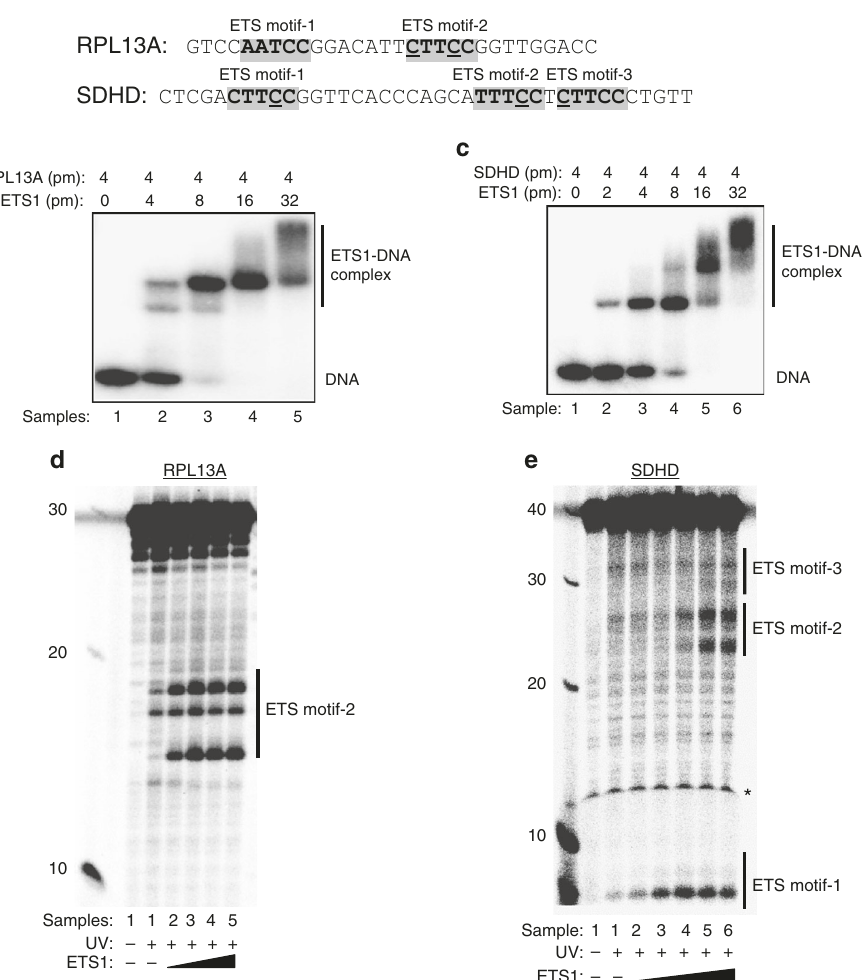
Fig. 5 Binding of ETS1 protein promotes UV damage formation in vitro. a DNA sequences of RPL13A and SDHD promoter fragments, corresponding to chromosome coordinates chr19:49990710-49990681 and chr11:111957515-111957553, respectively. Putative ETS motifs are shown in gray background and highlighted in bold. Recurrent mutated sites in melanomas are underlined. b, c Gel shift assays showing binding of puri fi ed ETS1 protein to radiolabeled RPL13A ( b ) and SDHD ( c ) promoter fragments, respectively. d A representative sequencing gel (15%) showing CPD formation in naked RPL13A (sample 1, with UV irradiation) and ETS1-bound RPL13A DNA (samples 2 – 5, UV irradiation). The binding products shown in part ( b ) were irradiated with 1KJ m − 2 of UV-C light and CPD lesions were converted to single strand breaks by T4 endonuclease V digestion. The resulting DNA breaks were separated on a 15% denaturing sequencing gel to analyze damage abundance at different locations. A negative control (naked DNA without UV irradiation) was also digested with T4 endoV to show the background level of DNA cleavage in the absence of UV-induced DNA lesions. The fi rst lane on the left shows a 10-nt DNA ladder. e Same as in part ( d ), except the SDHD promoter fragment was analyzed on a 12% gel. Asterisk indicates gel running artifact caused by bromophenol blue in the gel loading buffer. Both RPL13A and SDHD CPD formation experiments were conducted at least 3 times independently